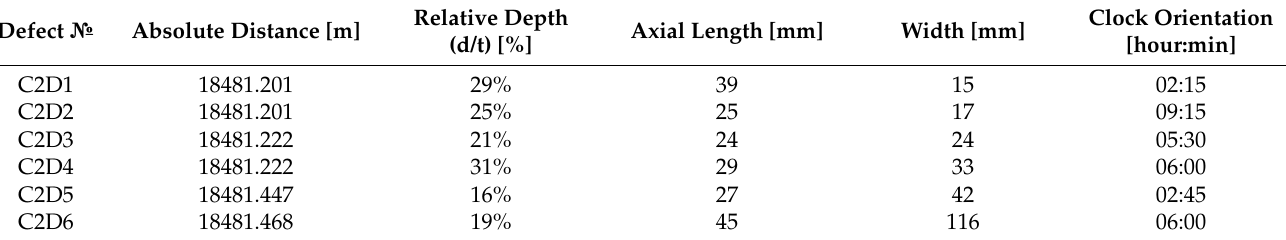
Table 2. Metal loss sizing in group 2. Source: Author’s